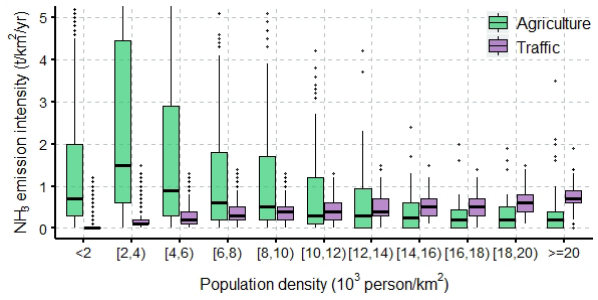
Figure 5. Distribution of agricultural and on-road NH 3 emissions among different population densities in 2019.